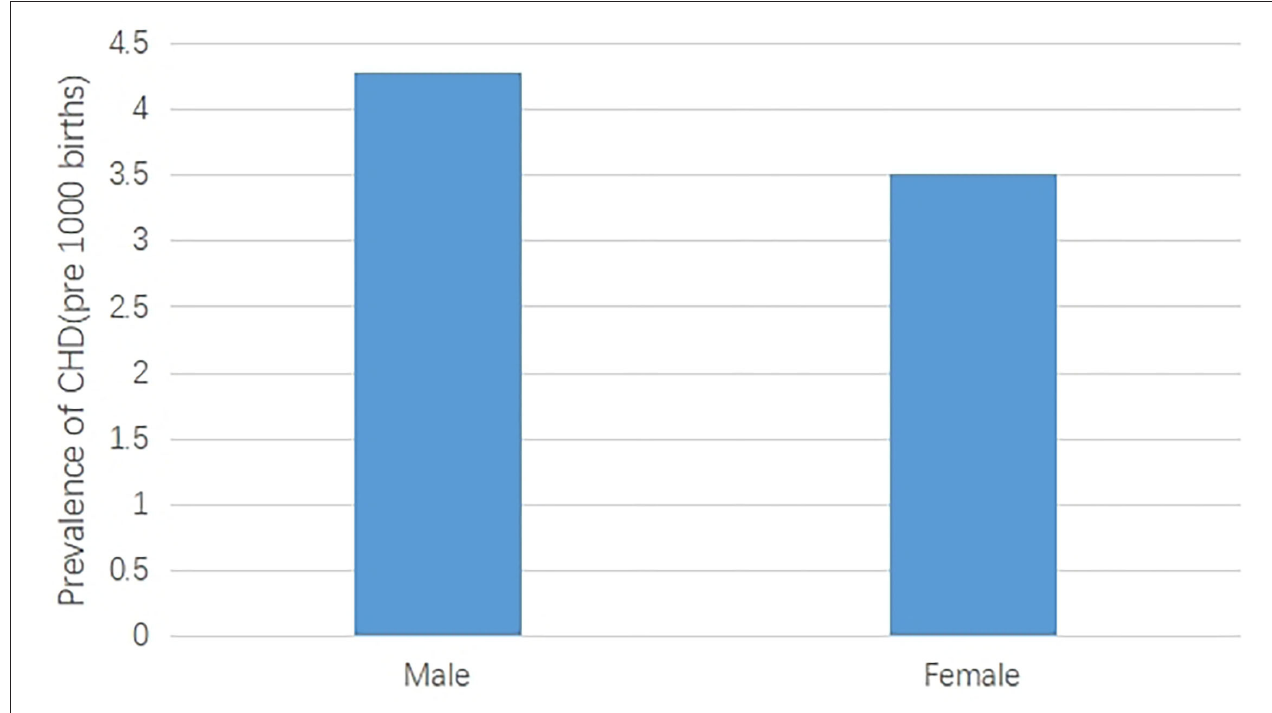
FIGURE 3 | The prevalence of CHD between male births and female births.